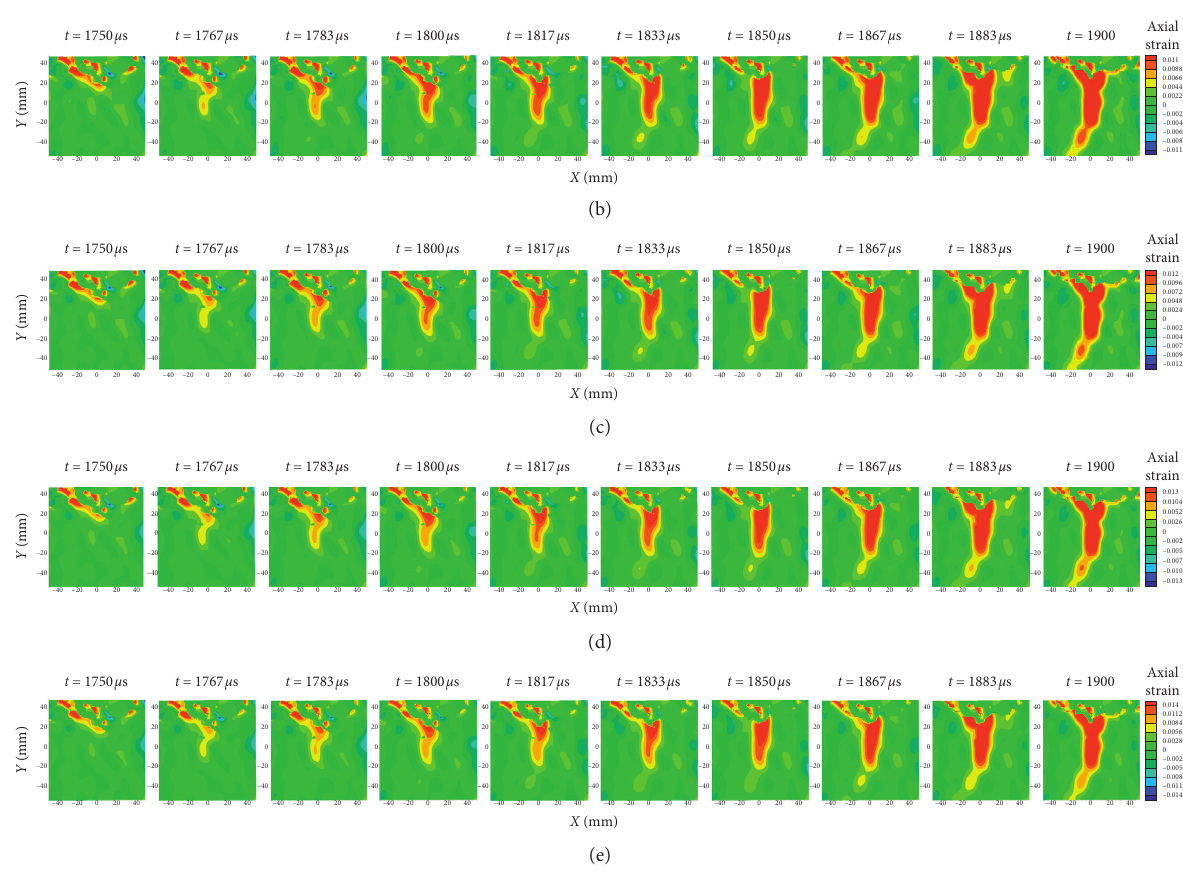
Figure 12: Evolutionary process of axial strain for different strain threshold values for test 3. (a) 1.0%, (b) 1.1%, (c) 1.2%, (d) 1.3%, and (e) 1.4%.